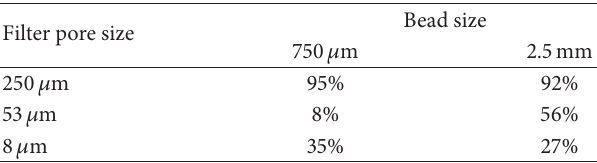
Table 3: Effect of filter pore size on the apparent solubilisation of chocolate (in %) in DS medium.